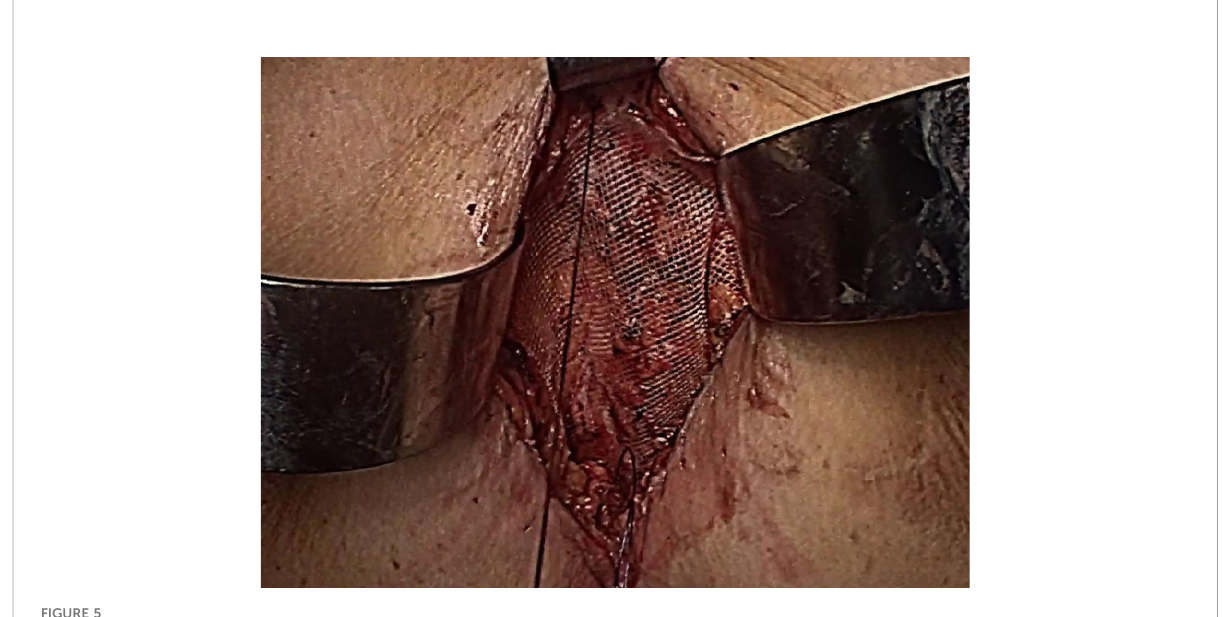
FIGURE 5 Placement of the